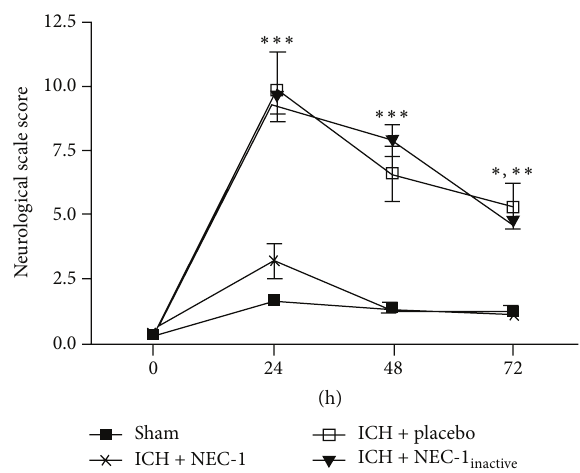
Figure 7: Nec-1 improves neurological outcome after ICH. Mice at the time of collagenase- were administered Nec-1 or Nec- 1 inactive induced ICH. Neurological outcomes were assessed at 24 h, 48 h, or 72 h following sham or ICH. Data are expressed as mean ± SEM ( 𝑛 = 10 /group) and were analyzed using a repeated measures ANOVA followed by Bonferroni’s post hoc test ( ∗ 𝑃 < 0.05 , ∗∗ 𝑃 < 0.01 , ∗∗∗ 𝑃 < 0.001